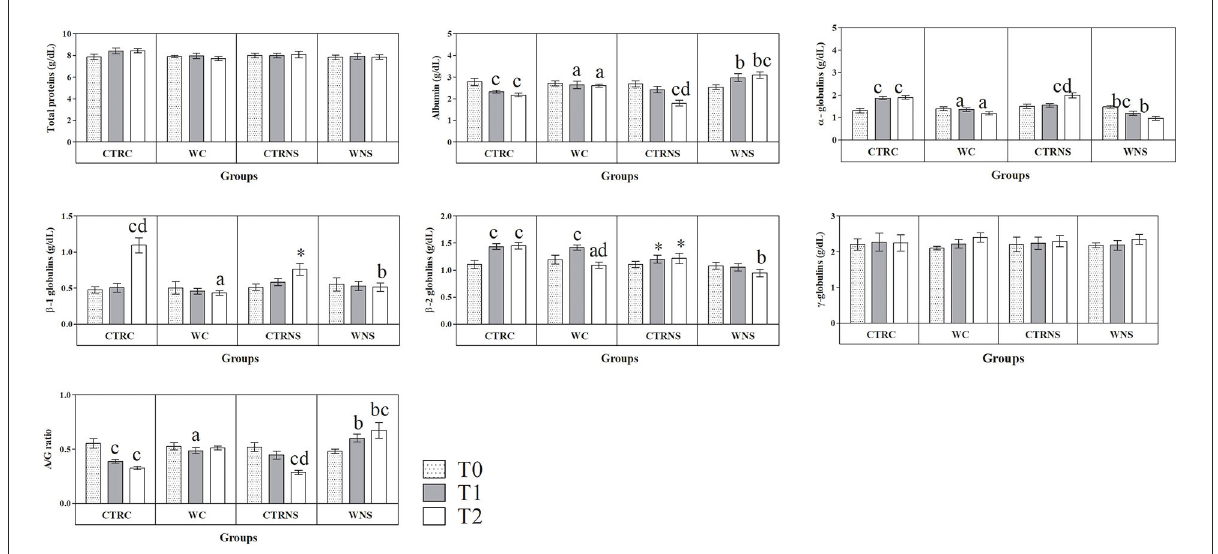
FIGURE3 Mean values ± standard error of the mean ( ± SEM) of serum total proteins, albumin, α -, β 1-, β 2- and γ -globulins, and A/G ratio obtained from pigs belonging to control fed and experimental dietary supplemented crossbreed LxLW groups (CTRC and WC) and Nero Siciliano breed (CTRNS and WNS) before (T0), one (T1) and two (T2) months after the starting of diet supplemented with